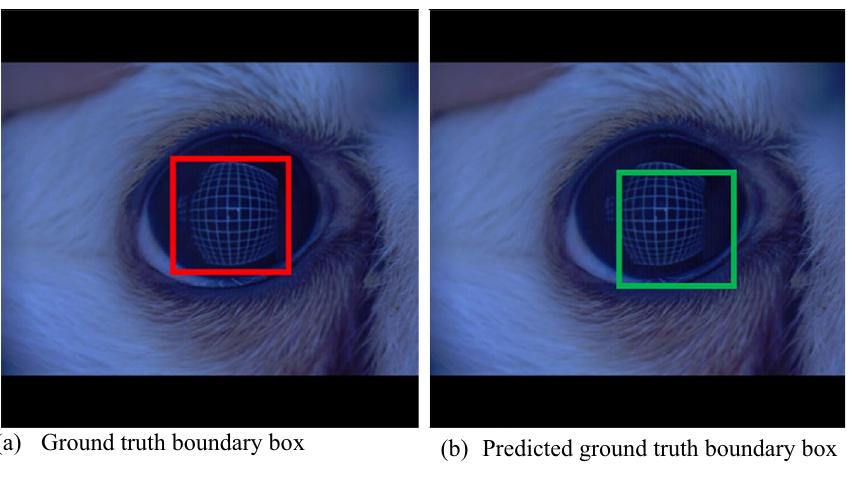
Figure 1. Ground truth boundary